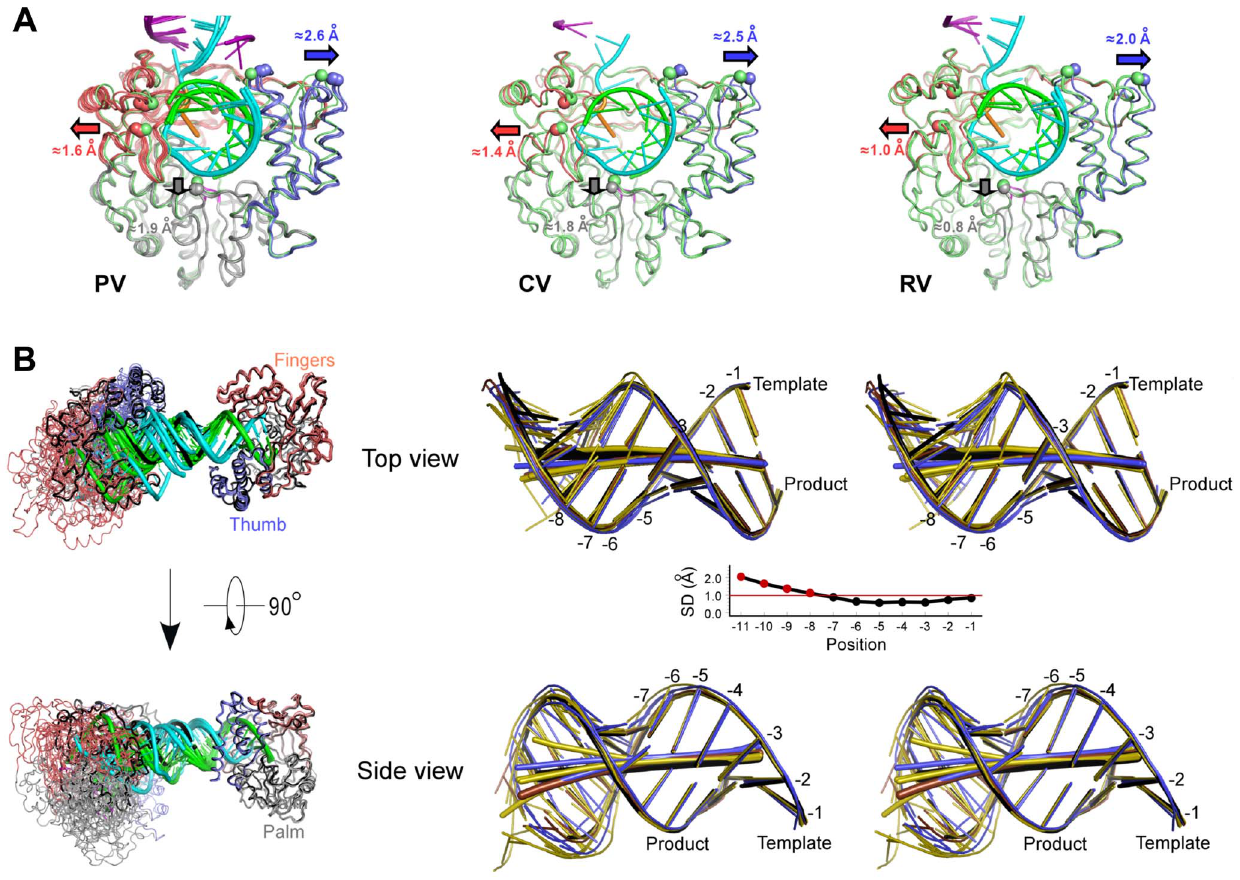
Figure 5. Polymerase front channel opening and conservation of RNA conformation. A) Opening of the polymerase front channel to accommodate the exiting RNA shown by the comparison of polymerase structures in their apo and elongation complex forms. All ECs follow the three-color coding scheme while the apo polymerases are shown in green. From left to right: all five PV ECs compared to one apo form (PDB code 1RA6); one CV EC compared to two apo forms (PDB codes 3DDK and 3DCU); two RV ECs compared to two apo forms (PDB code 1XR7 chains A & B). The major conformational differences are highlighted by blue, pink, and grey arrows indicating the movement within the thumb, fingers, and palm domains, respectively. The a -carbon atoms and displacement distances of PV polymerase residues 408 and 440 in the thumb, 102 and 133 in the pinky finger, and 211 in the palm, and their structural equivalents in CV and RV polymerases, are shown as spheres to further highlight the movements. B) Maximum likelihood superimposition of all eight distinct (i.e. not NCS-related) EC dumbbell pairs with the protein backbone C a atoms of the right side polymerase being used for the alignment. The RNA from the PV_r3 EC pair that contains the most ‘‘straight’’ RNA-RNA junction is shown in black for reference, other complexes are colored as in Figure 2, and the downstream template RNA is omitted for clarity. Two views are shown to better depict the three dimensional variation of the partner complexes, with the ‘‘Top view’’ looking down into the active site and the ‘‘Side view’’ looking into the NTP entry channel. C) Stereo images of the upstream RNA duplex positions resulting from the protein-based structure alignment shown in panel B. The referencing PV_r3 duplex is in black, other PV duplexes are in yellow, CV duplex is in brown, and RV duplexes are in blue. The RNA helical axes as calculated by nucleic acids analysis program Curves + are shown in thick sticks using the same coloring scheme. Consistent RNA conformations are observed from position 2 1 to position 2 8, with significant lateral variation of the base pairing starting around the 2 7/ 2 8 base pair step. The middle panel shows the standard deviation of the RNA axis positions at each base step, mathematically suggesting that the upstream duplex conformation is only affected by the variation at the inter-complex junction beyond the 2 8 position. This corresponds to the point at which the RNA duplex exits from the polymerase and no longer contacts the thumb